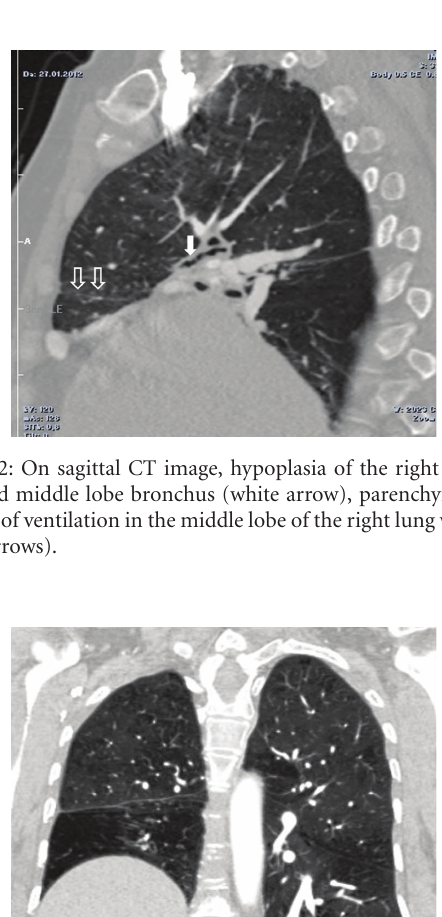
Figure 1: On the PA chest radiography, the volume of the right hemithorax was decreased and the hemidiaphragm elevated. The right pulmonary hilus was small, and hyperlucency and decrease of peripheral vascular shadowing of the right lung were detected.